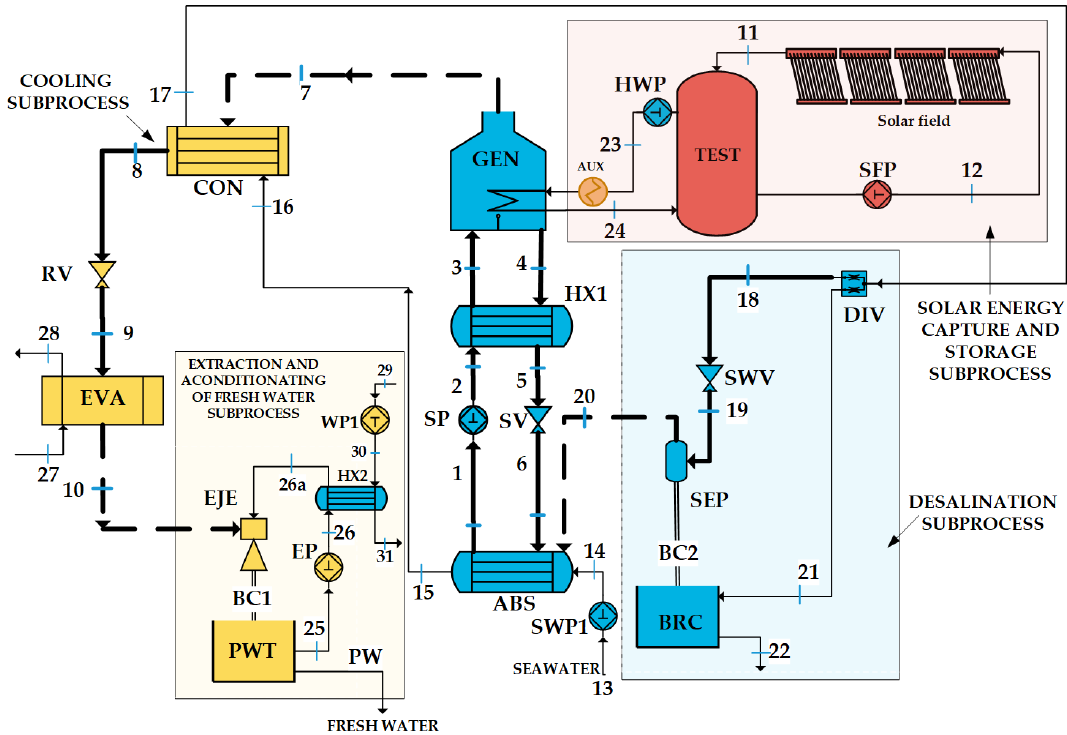
Figure 1. Schematic diagram of hybrid solar absorption-cooling and flash-desalination system.